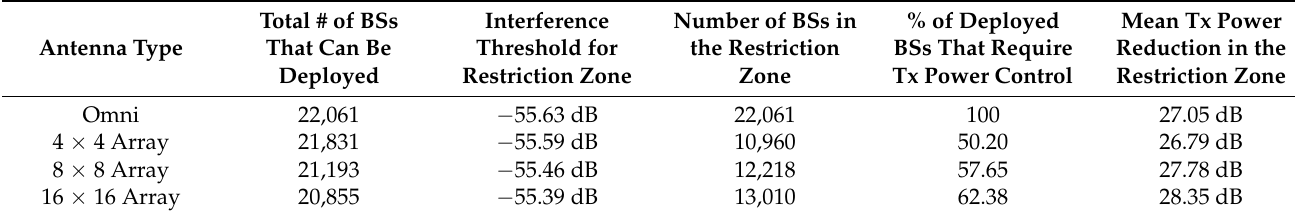
Figure 31. Tx power control chart in UMi scenario. Table 6. Mean Tx power reduction in the restriction zone and BS Tx power control in UMi.